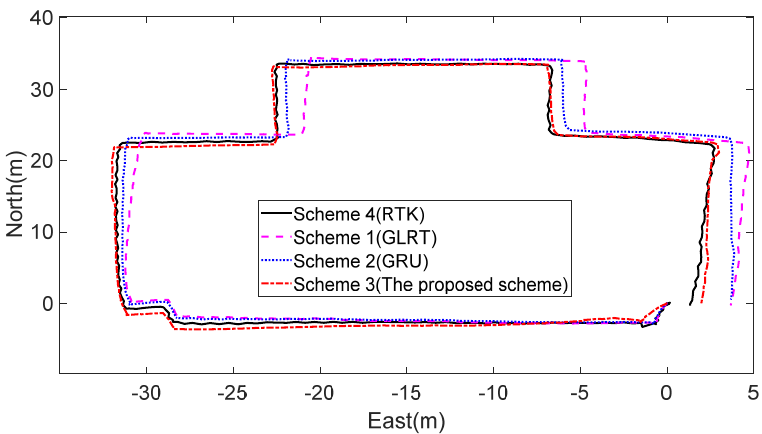
Figure 8. 2D positioning trajectories by different methods.